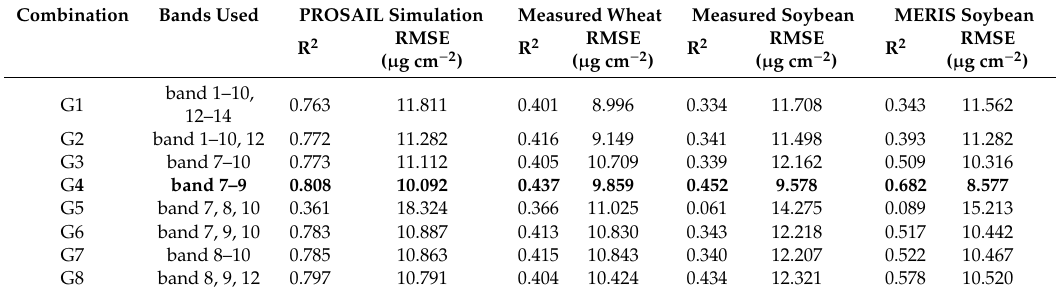
Table 6. Comparisons of LCC retrieval performance using di ff erent combinations of MERIS bands. Combination